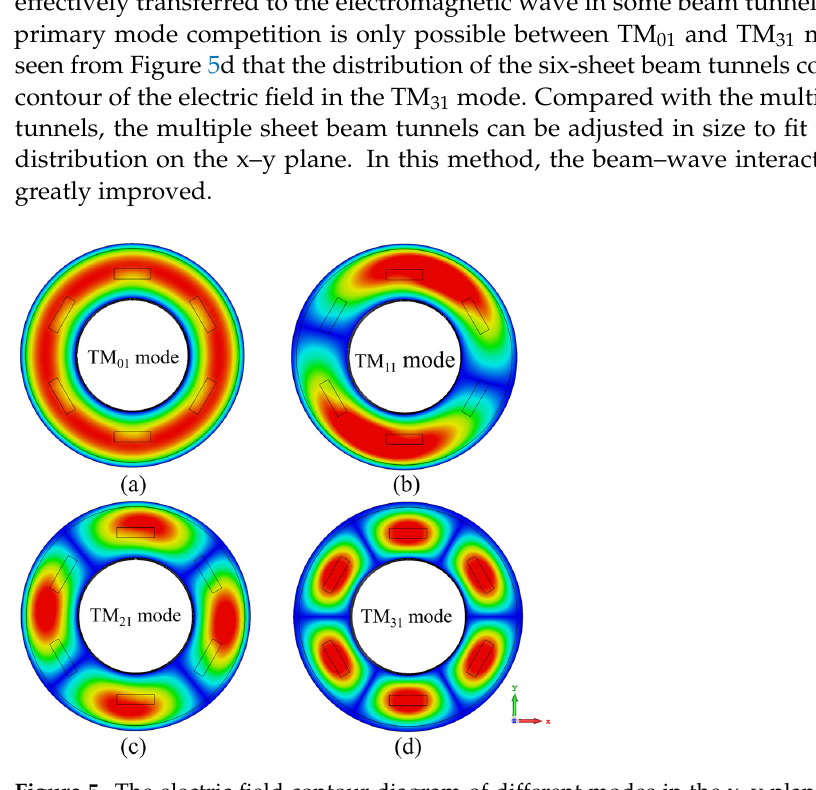
1 𝛽 (cid:2870) (cid:2870) (cid:3032) 𝐺 (cid:3404) (cid:4670)(cid:3627)𝑀(cid:3435)𝛽 (cid:3398) 𝛽 (cid:3439)(cid:3627) (cid:3398) (cid:3627)𝑀(cid:3435)𝛽 (cid:3397) 𝛽 (cid:3439)(cid:3627) (cid:4671) (1) (cid:3032) (cid:3032) (cid:3044) (cid:3032) (cid:3044) 𝛽 8 (cid:3044)